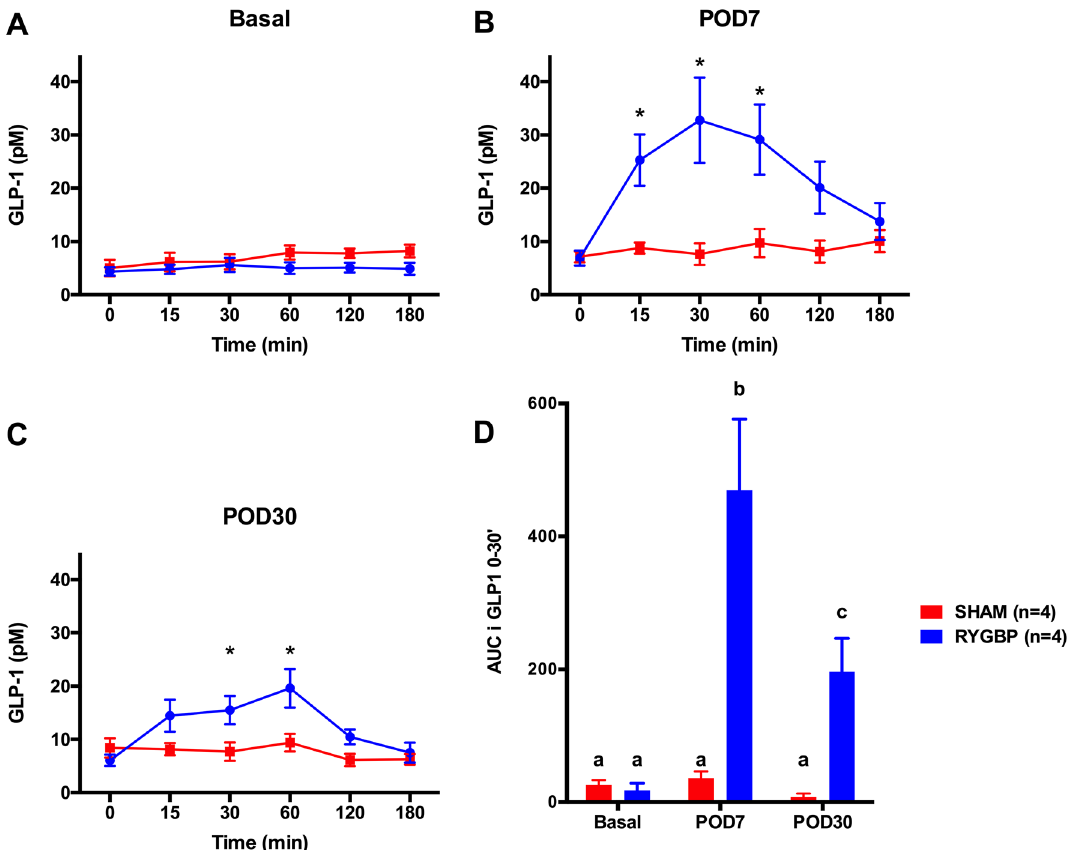
Figure 2. OGTT results before surgery (preoperative, baseline) ( A ), and at postoperative day (POD) 7 ( B ) and POD 30 ( C ). * p < 0.05. Incremental area under the curve (AUCi) of GLP-1 secretion 0–30 min after glucose ingestion ( D ). Letters indicate a significant statistical difference at p < 0.05. All values are expressed as means ± SEM